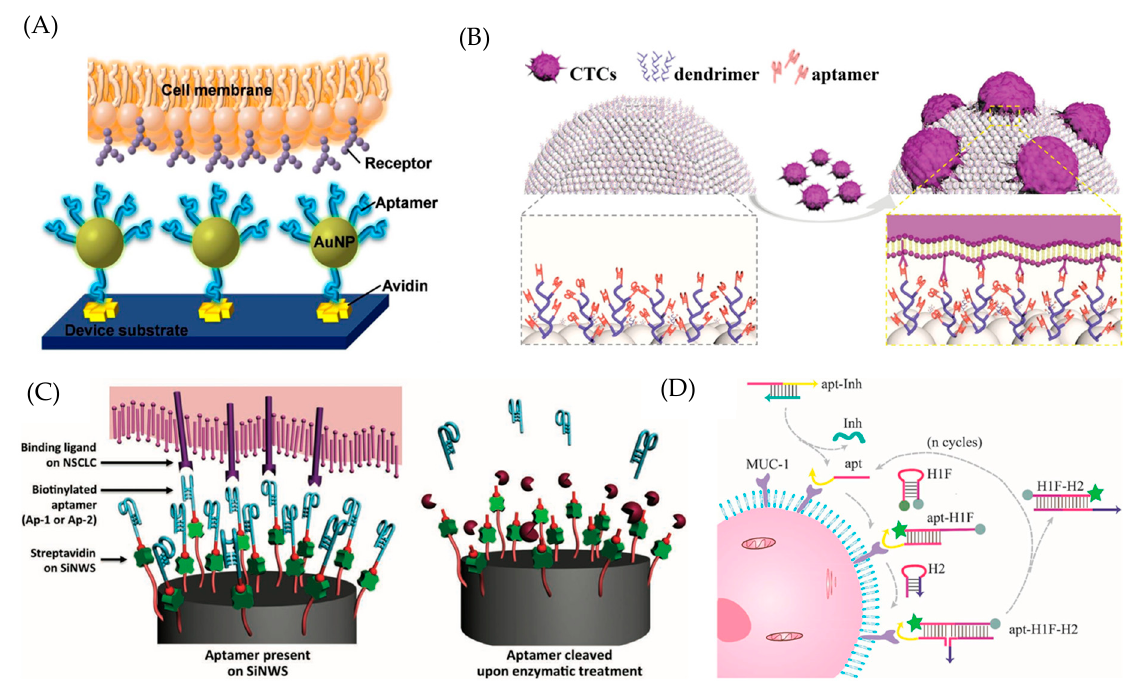
Figure 3. Schematic illustration of aptamer-based techniques for the capture and detection of circulating tumor cells (CTCs). ( A ) Multivalent AuNP-aptamer for the enhanced capture of tumor cells on microdevices. Reprinted with permission from ref. [126]. ( B ) SiNW-based platform for CTC capture and release with temperature stimulation. Reprinted with permission from ref. [127]. ( C ) NanoVelcro Chip consisted of aptamer-coated silicon nanowire substrate (SiNWS) and an overlaid PDMS chaotic mixer. Reprinted with permission from ref. [128]. ( D ) Bi-functional aptamer-mediated catalytic hairpin assembly for the fluorescence turn-on detection of rare cancer cells. Reproduced with permission from ref. [129].